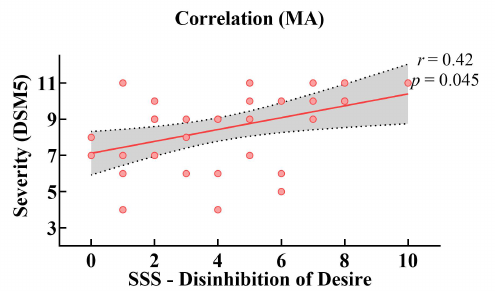
Figure 5. Scatter plot of the Disinhibition of Desire subscales of Sensation Seeking Scale and MUD severity with regression lines and 95% CIs in the MUD group. The severity of MUD was measured by DSM-V. Note: r , Pearson correlation coefficient; p values corrected by